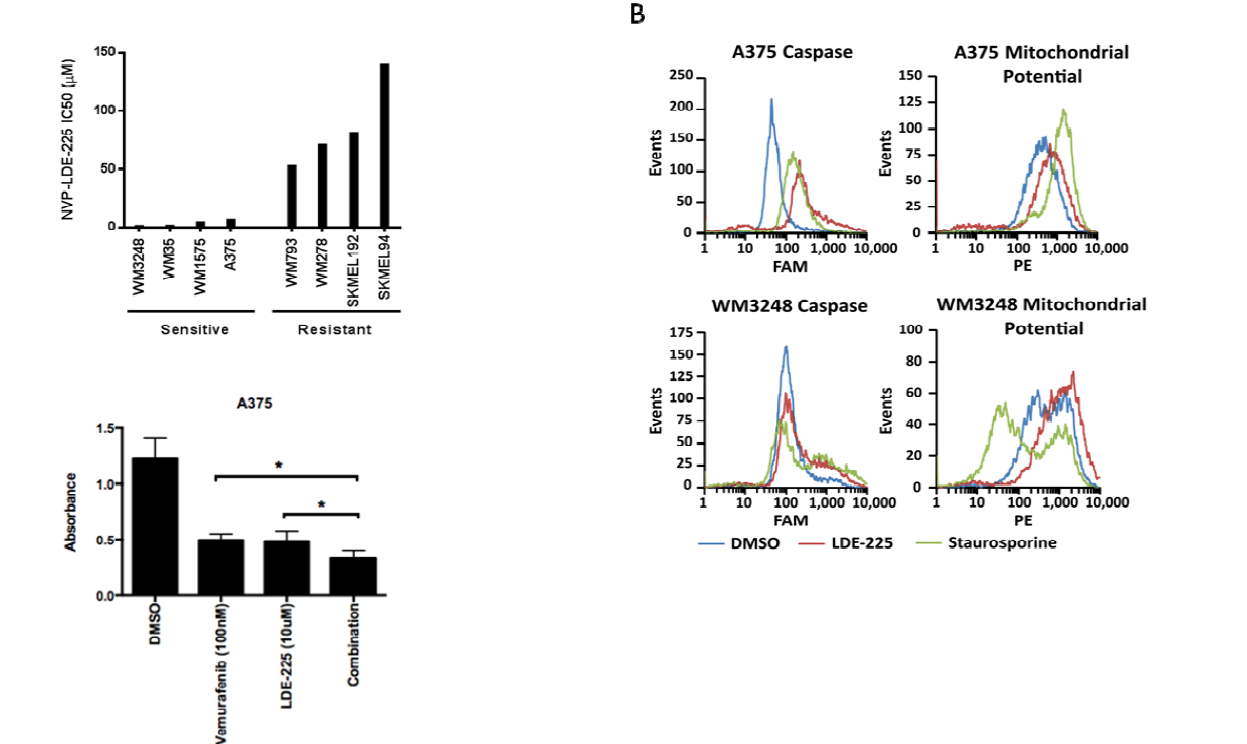
Figure 5. The SMO inhibitor NVP-LDE-225 inhibits proliferation in primary and metastatic melanoma cell lines in vitro . ( A ) Primary and metastatic melanoma cell lines demonstrate variable sensitivity to NVP-LDE-225. Cell lines harboring modest expression of GLI2 and SMO are more sensitive to NVP-LDE-225 (IC < 15 µM) as compared to 50 those cell lines with overexpression of GLI2 and SMO (WM278 and WM793) or lack of pathway activity (SkMel94 and SkMel100) (IC > 50 µM). ( B ) 10 µM NVP-LDE-225 50 induces apoptosis in A375 and WM3248 cells as detected by an increase in pan-caspase positive cells and in cells with loss of mitochondrial membrane potential after 72 h of treatment. ( C ) Combination LDE-225 (10 µM) and vemurafenib (100 nM) inhibits proliferation better than either single agent or vehicle after 72 h of treatment ( * , p < 0.003). In A–B, values represent the mean from a representative experiment performed three times with similar results. In C, values represent the mean ± standard deviation from a representative experiment performed three times with similar